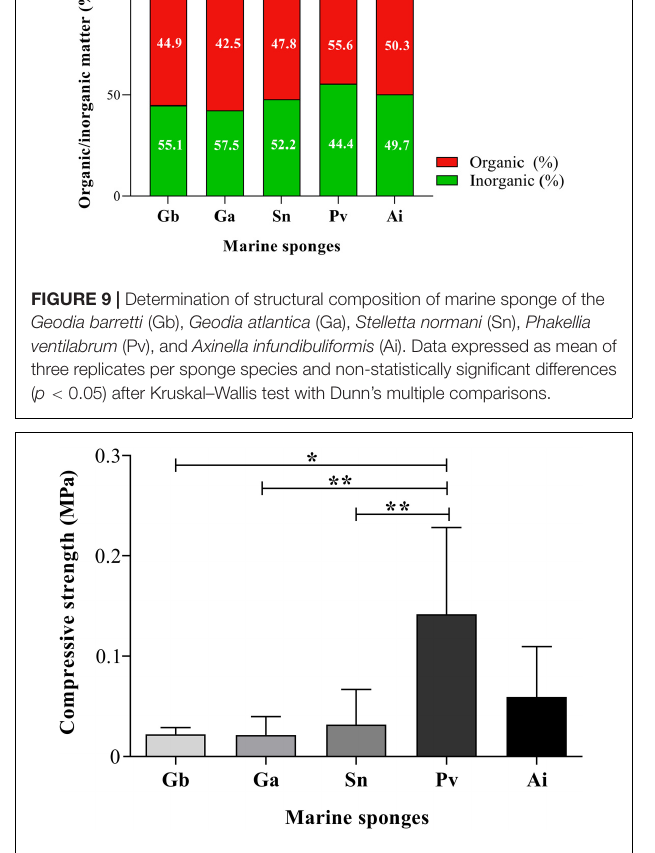
FIGURE 10 | Compressive modulus of the dried sponges. The asterisks indicate statistically significant differences (* p < 0.05 or ** p < 0.005) after Kruskal–Wallis test with Dunn’s multiple